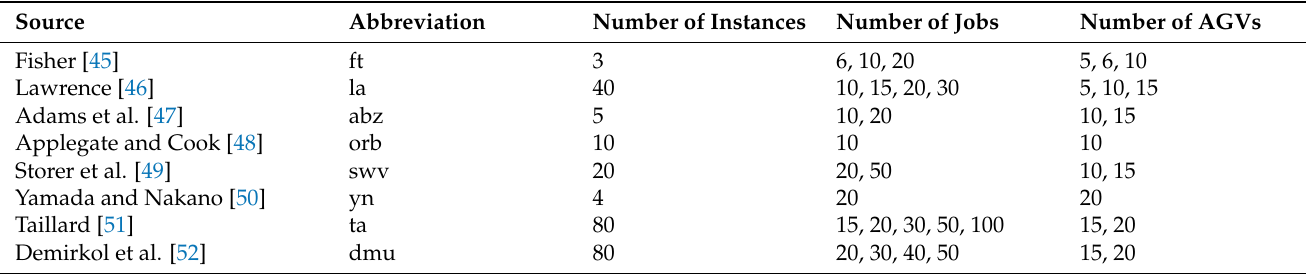
Table 1. Overview of the JSSP literature benchmark instance